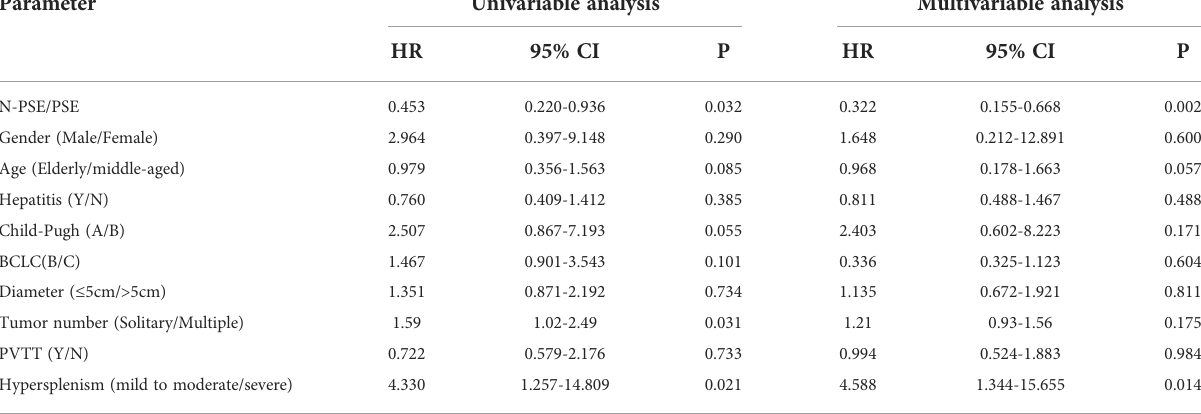
TABLE 11 Univariate and multivariate analysis on parameters affecting overall survival (OS).